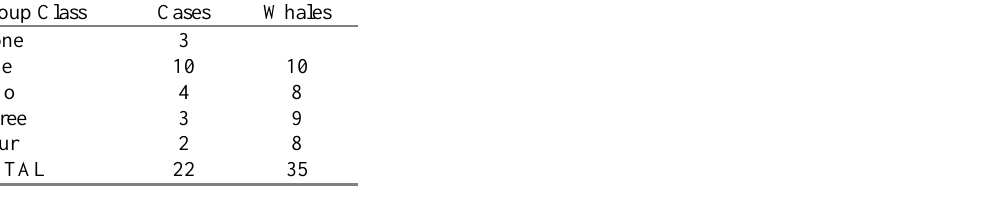
Animals associated to the nuclear animal along the entire observation period according their social class Group Class